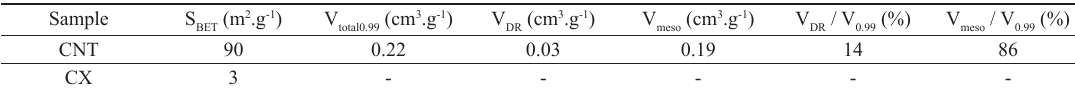
), total pore volume (V BET